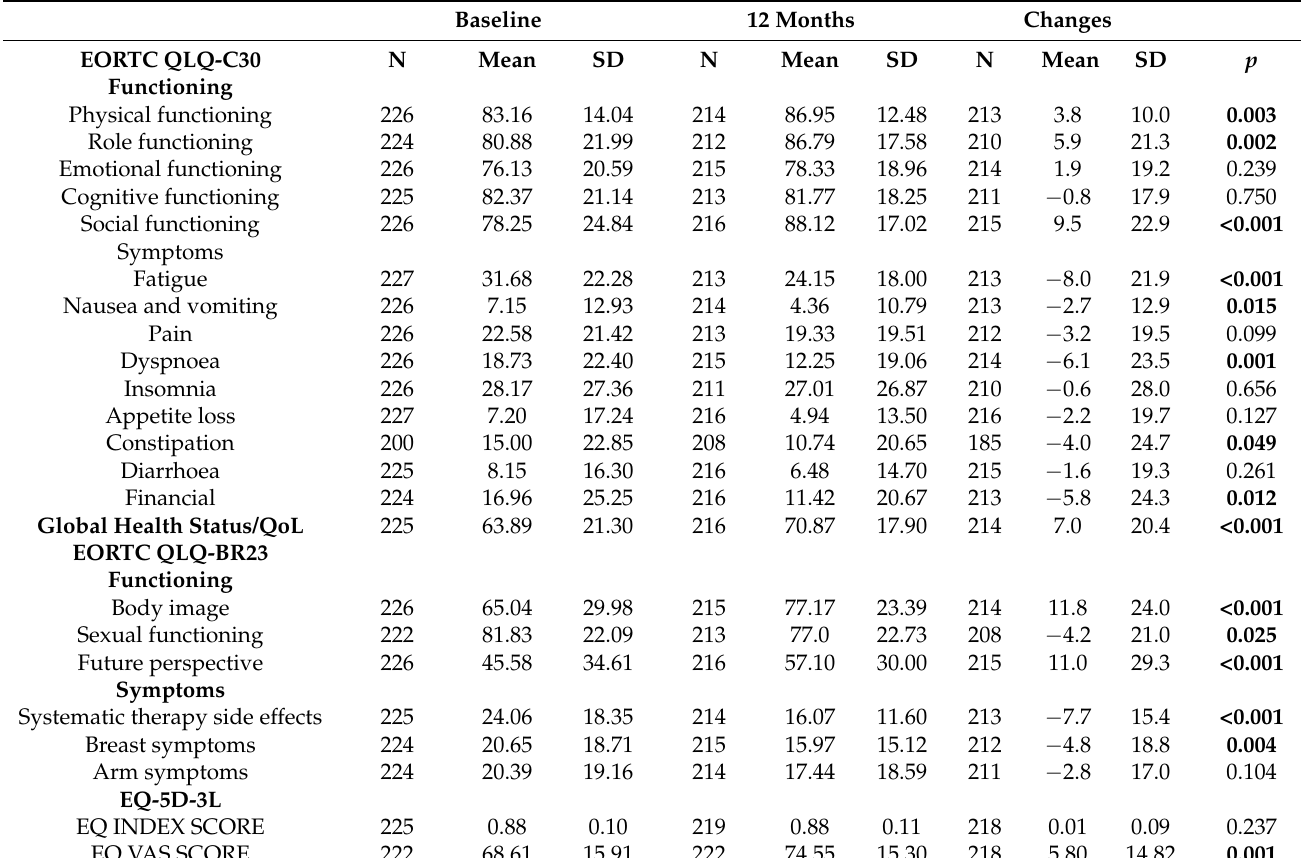
Table 2. Comparison of European Organization for Research and Treatment of Cancer Quality of Life Questionnaire Core 30 items (EORTC QLQ-C30), Breast Cancer 23 items (EORTC QLQ-BR23), and European Quality of Life 5 Dimensions 3 Level (EQ 5D 3L) scores of participants at baseline and at 12